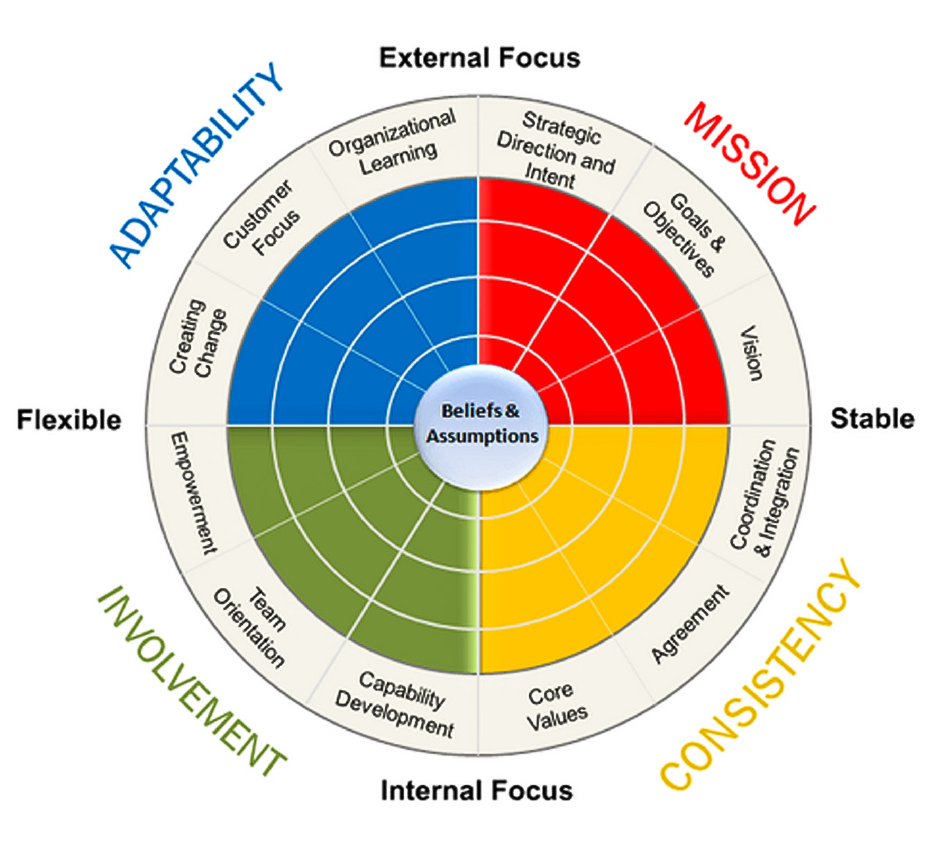
Figure 3. Denison’s model of organizational